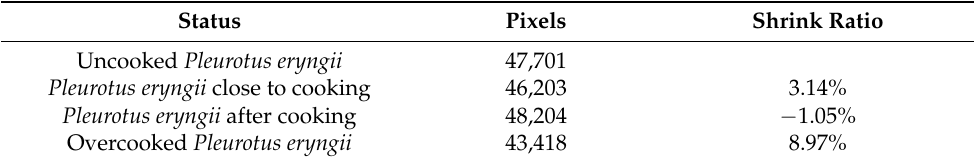
Table 2. The number and shrinkage ratio of Pleurotus eryngii in different cooking stages.